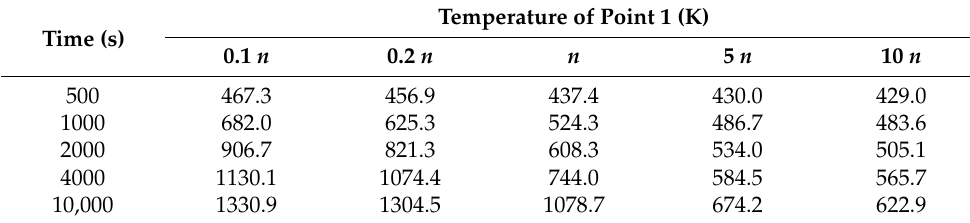
Table 8. Temperature with different expansion rates at different times.